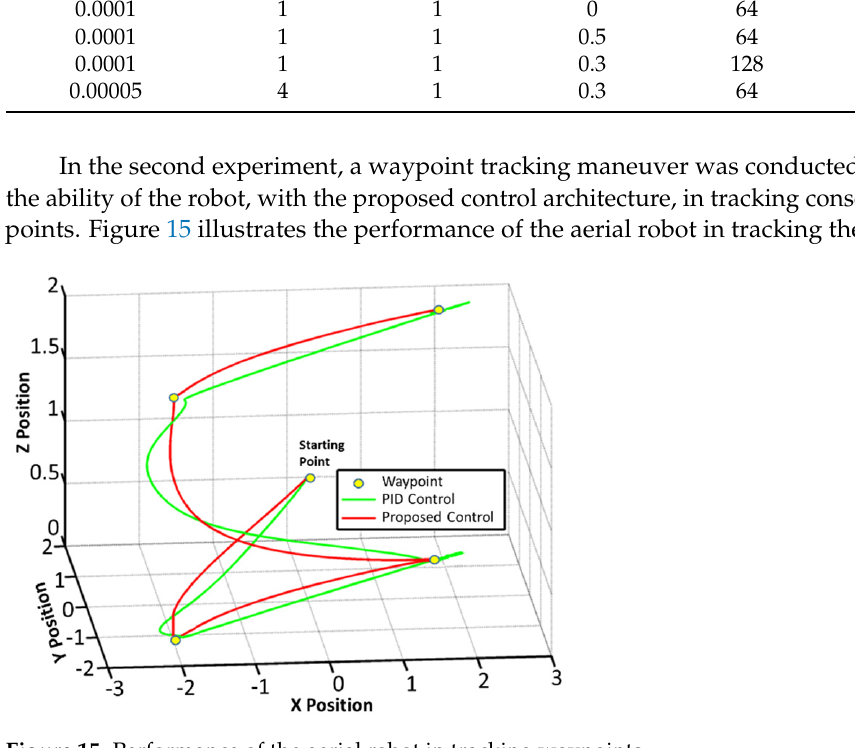
Table 5. Variation of RL hyperparameters and their effect on the steady-state error.